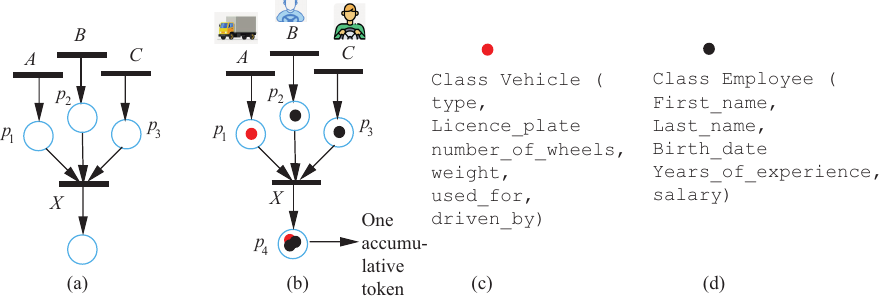
Figure 3. ( a ) Modeling Scenario 3, ( b ) the effects after predecessors fire, ( c , d ) pseudo-code for the declaration of two different entities.